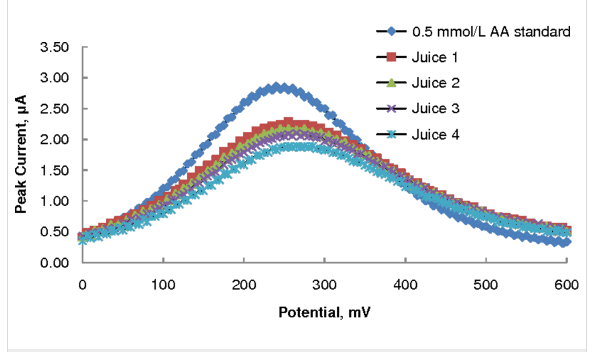
Figure 5: SWV voltammograms of four commercial orange juice samples (diluted by 1/5) in acetate buffer, pH 3.7; 0.5 mmol/L AA standard shown for comparison.